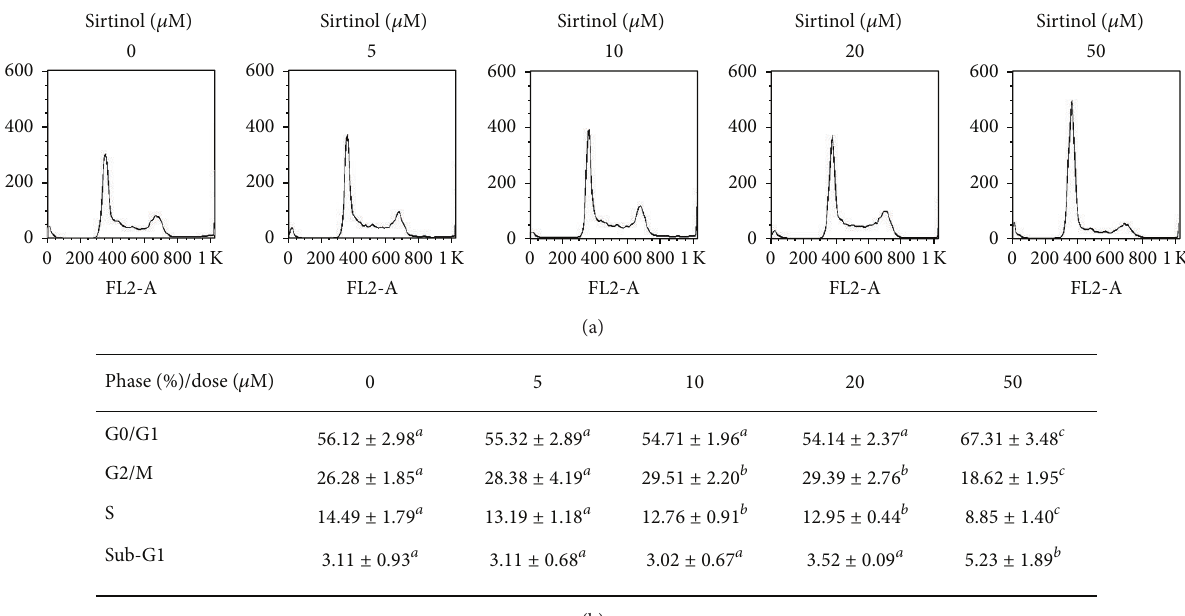
Figure 3: The effect of sirtinol on cell cycle distribution of lung cancer cells. H1299 cells treated with indicated concentrations (from 5 to 50 𝜇 M) of sirtinol for 24 h, respectively. Cells were stained with PI and detected the cell cycle distribution by flow cytometry. (a) Flow cytometry profile represents PI staining in 𝑥 -axis and cell number in 𝑦 -axis. (b) The quantitative analysis of cell cycle distribution. Different letter notations indicate the statistical significance between drug treatment and vehicle ( a versus b and a versus c indicate the 𝑃 < 0.05 and 0.001,